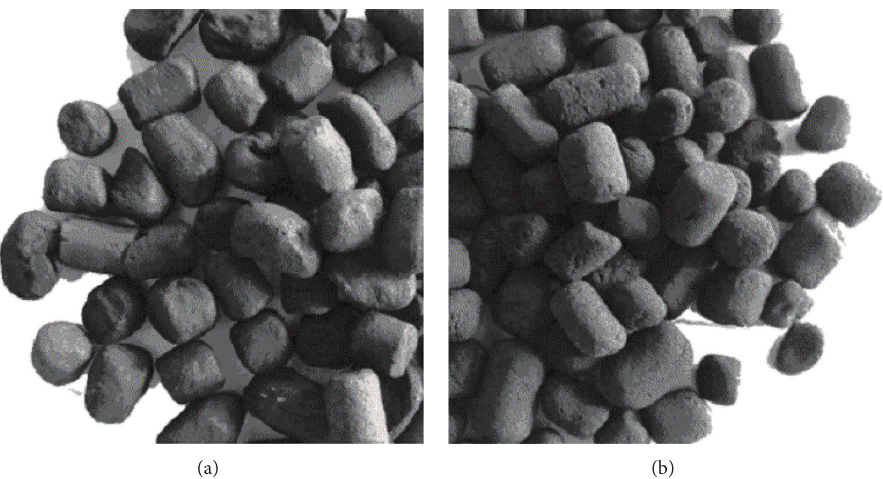
Figure 2: How particles of fresh active coke change in shape and dimensions after abrading.